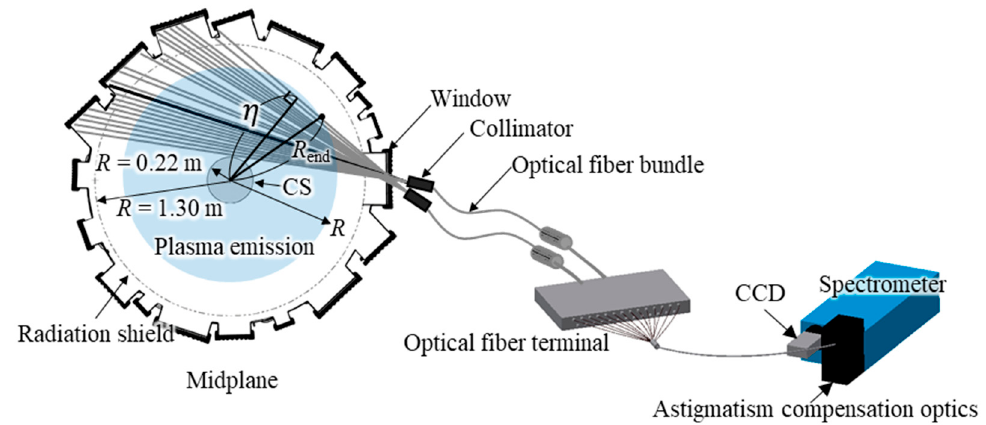
Figure 2. Schematic illustrations of the cross-section of the Q-shu University Experiment with Steady-State Spherical Tokamak (QUEST) midplane and the visible spectroscopic system.